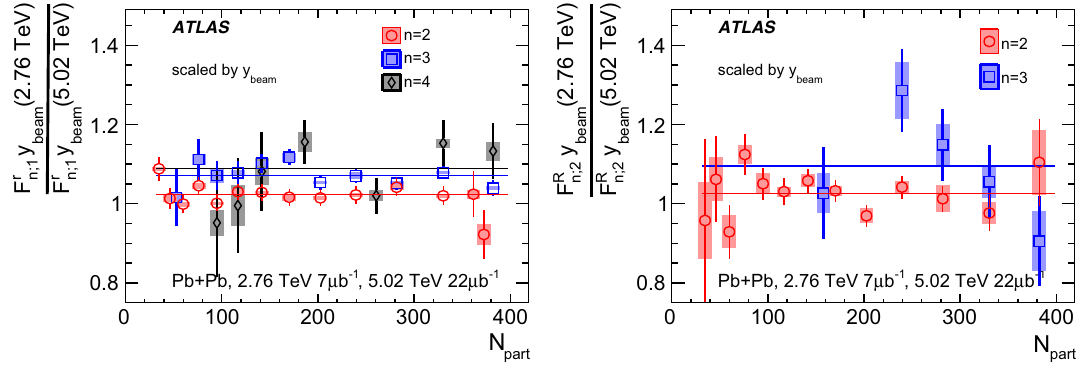
≡ F r ≡ F R y beam and ˆ F R y beam valuesatthetwoenergiesintherange30 < N part < 400 , F R , ˆ F r n ; 1 n ; 2 n ; 1 n ; 1 n ; 2 n ; 2